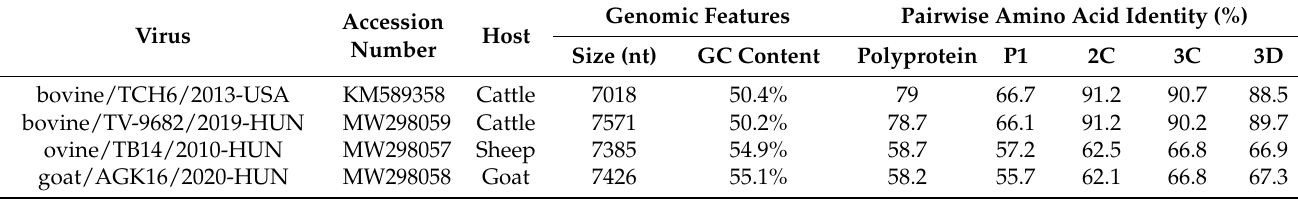
Table 2. Comparison of genomic features of deer/VIC82-2020/AUS (MZ436972) and described bopiviruses.